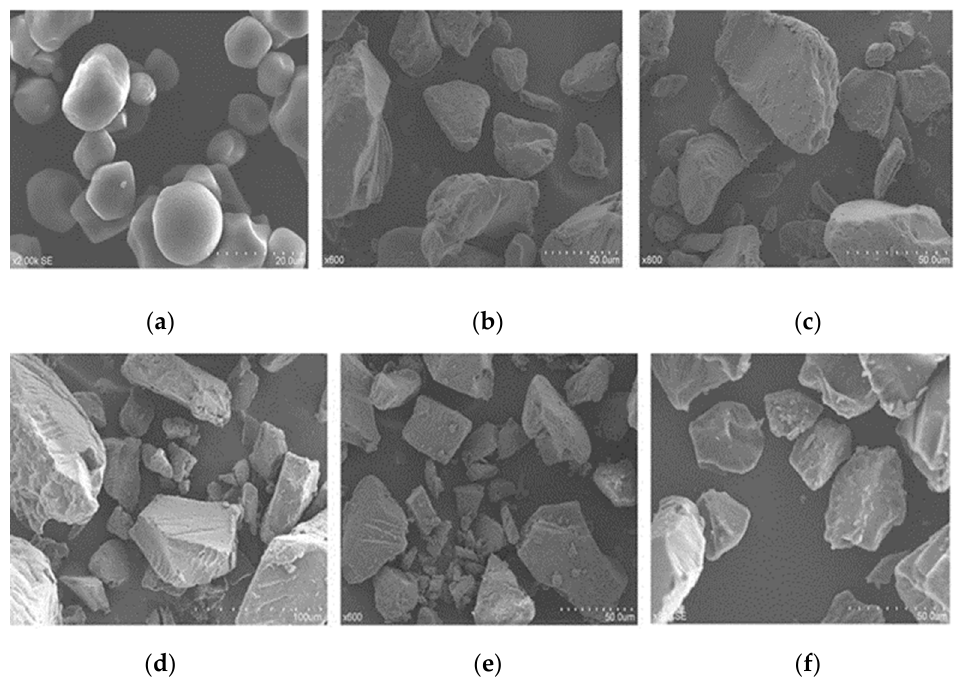
Figure 2. SEM images of ( a ) native corn starch, ( b ) gelatinized corn starch without enzymatic modification ( α -amylase, 0 U/g; pullulanase, 0 U/g), ( c ) dual enzyme-treated starch ( α -amylase, 2 U/g; pullulanase, 8 U/g), ( d ) dual enzyme-treated starch ( α -amylase, 4 U/g; pullulanase, 8 U/g), ( e ) dual enzyme-treated starch ( α -amylase, 8 U/g; pullulanase, 8 U/g) and ( f ) single enzyme-treated starch ( α -amylase, 0 U/g; pullulanase, 8 U/g).